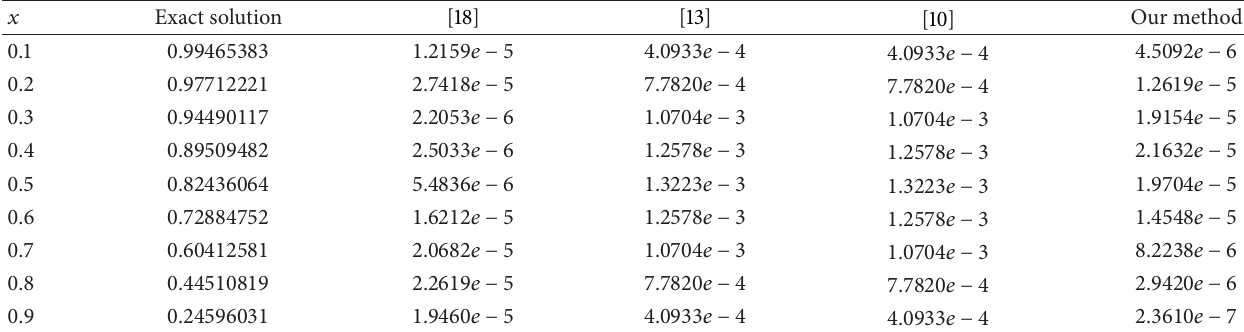
Table 3: Max [𝑦(𝑥 𝑖 )] of different methods for Example